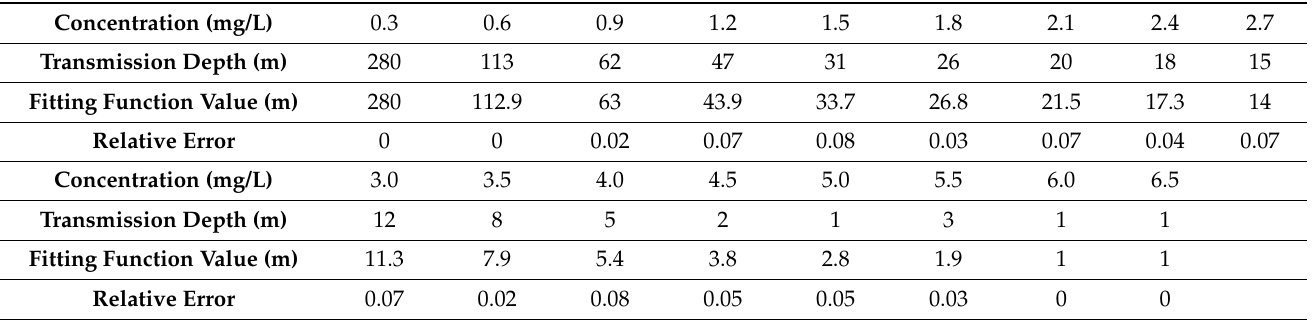
Figure 4. Maximum transmission depth for seawater containing different suspended matter concentrations. Table 4. Comparison between the simulation value of maximum transmission depth and the value of the fitting